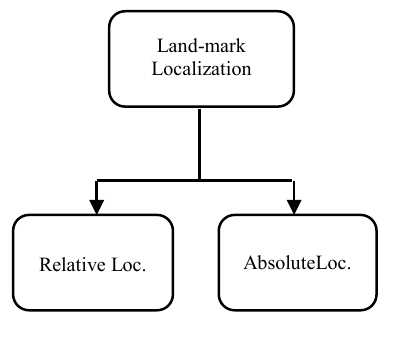
Fig. 1. Classification of land-mark localization.